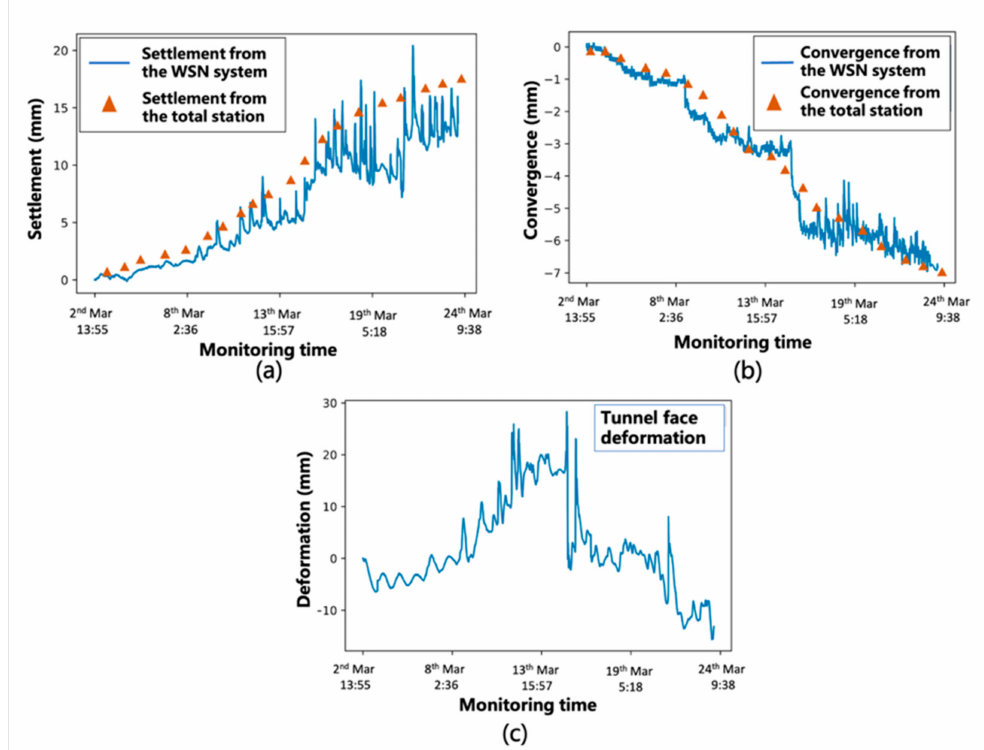
Figure 10. Monitored deformation data of the transverse section (Section 1) in front of the tunnel face: ( a ) crown settlement; ( b ) horizontal convergence; ( c ) tunnel face